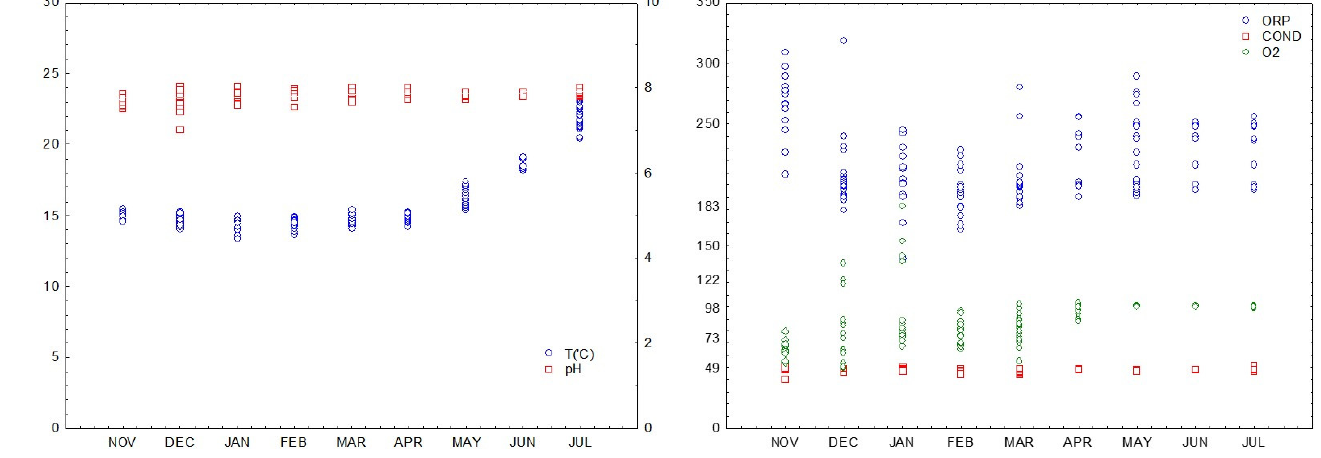
Figure 2. Relationship of total weight (TW), soft body wet weight (SBW) and shell weight (SW) to shell height (SH) of A. opercularis individuals.